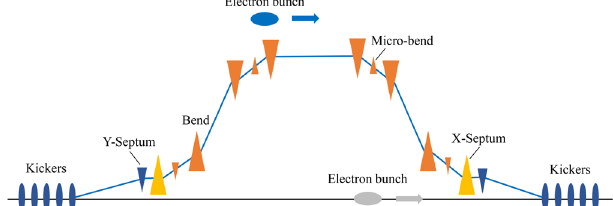
FIG. 2. Schematic layout of the electron beam delay system and the kickers. Quadrupoles between the dipoles are not shown